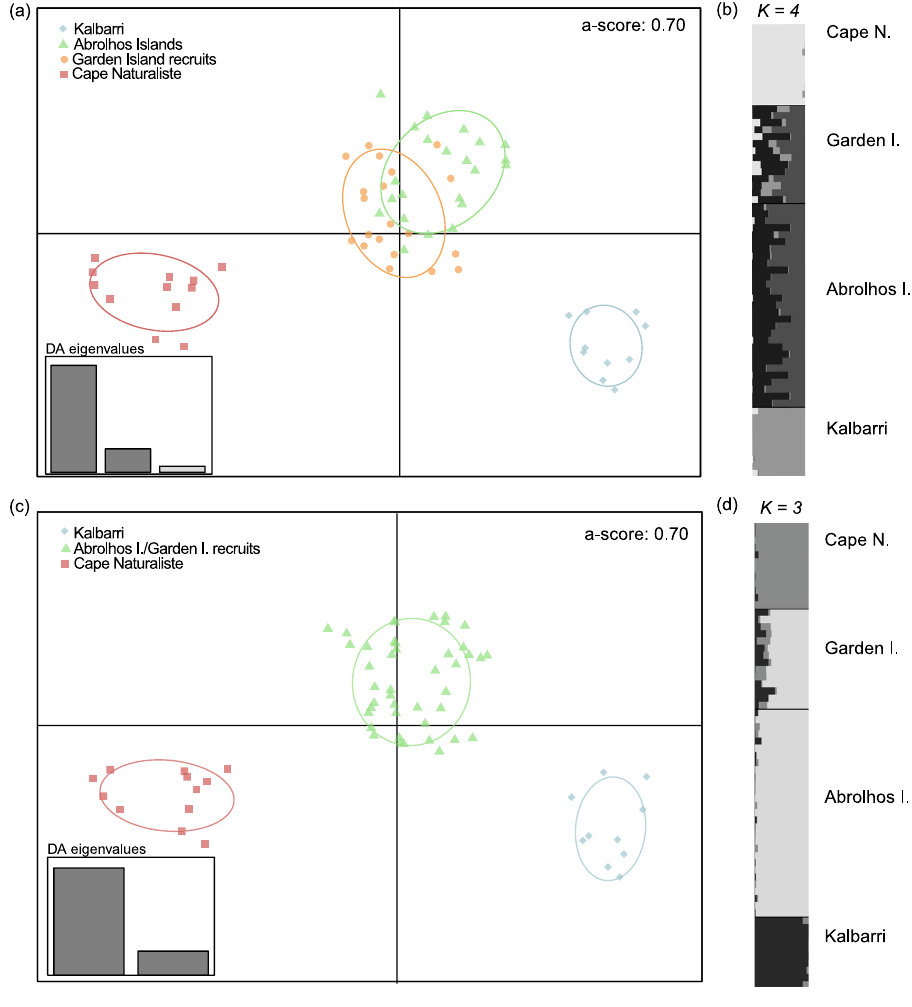
Figure 2. Structure of outlier loci (n = 282) from Choerodon rubescens populations. Two discriminant analysis of principle components (DAPC) are presented: ( a ) shows original populations as clusters ( K = 4), and ( b ) the scenario with K = 3 selected as the optimal number of clusters via Bayesian analyses (BIC, see Supplementary Fig. S3 for K selection information). For each DAPC the associated alpha score (a-score) is shown; geographical origin of each population is depicted by colours and 95% inertia ellipses; individual genotypes are represented by different shaped dots (diamonds, triangles, circles and squares); eigenvalues show the amount of genetic information contained in each successive principal component. ( b ) and ( d ) show bar plots from Bayesian clustering analyses using STRUCTURE for K = 4 and K = 3 respectively; each individual is represented by a vertical column partitioned into K segments (grayscale); see Appendix 4 for plots of log probability L( K ) and Δ K across different values of K . Fish at Kalbarri, Abrolhos, and Cape Naturaliste are adults ( ≥ 350 mm L while the population at Garden Island is represented exclusively by recruits ( ≤ 130 mm L T , 0 + yrs). See Table 1 for sample